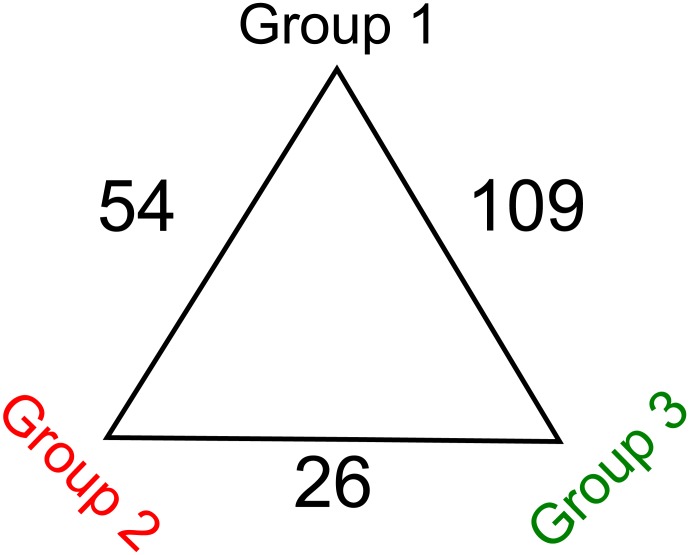
Descriptive analysis of the Metastats.Numbers indicates the numbers of OTUs differentially present in the different groups of individuals. For details on the identities of the OTUs, please refer to the table 3; 4 and 5.